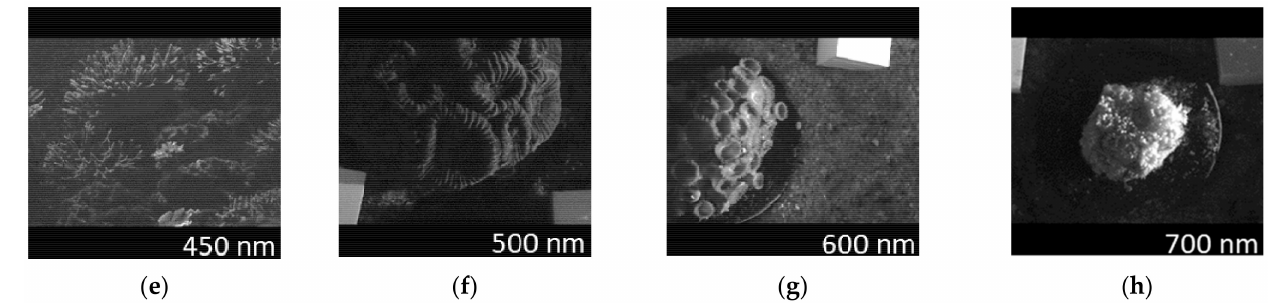
Figure 4. Coral images preprocessing: ( a ) RGB image; ( b ) R channel; ( c ) G channel; ( d ) B channel; ( e – h ) Preprocessed spectral images.